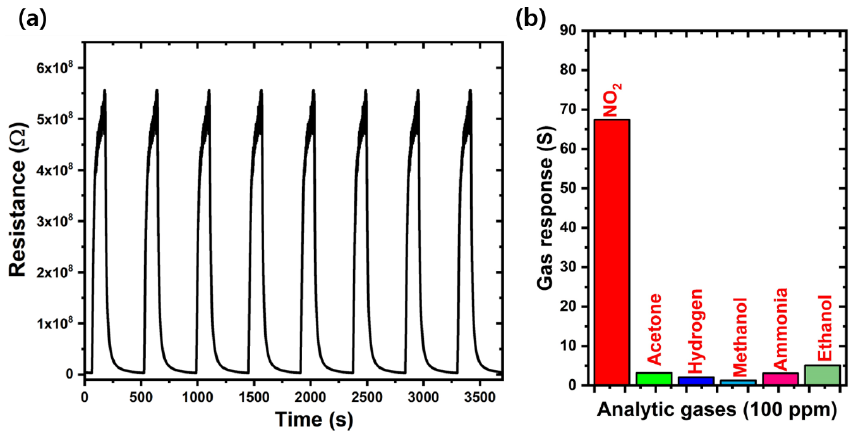
Figure 6. ( a ) Eight cycles of response – recovery curves towards 50 ppm NO 2 at the operating temperature of 100 °C, ( b ) selectivity measurements of SnO 2 /ZnO heterostructures towards various test gases with concentrations of 100 ppm.